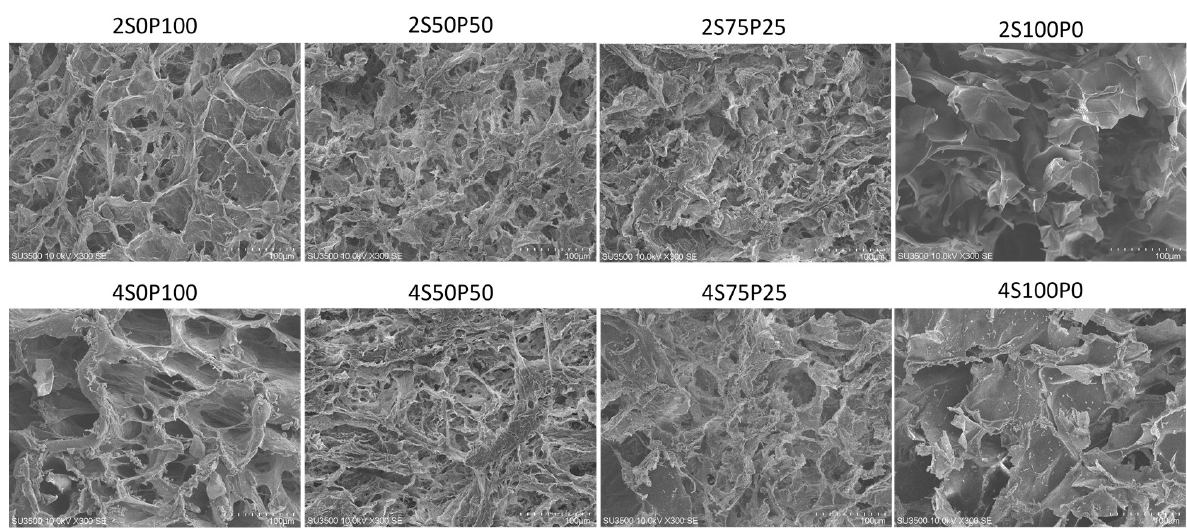
Figure 4. SEM images of the hydrogel cross-section at a concentration of 2% and 4% with various sericin and PVA ratio compositions.